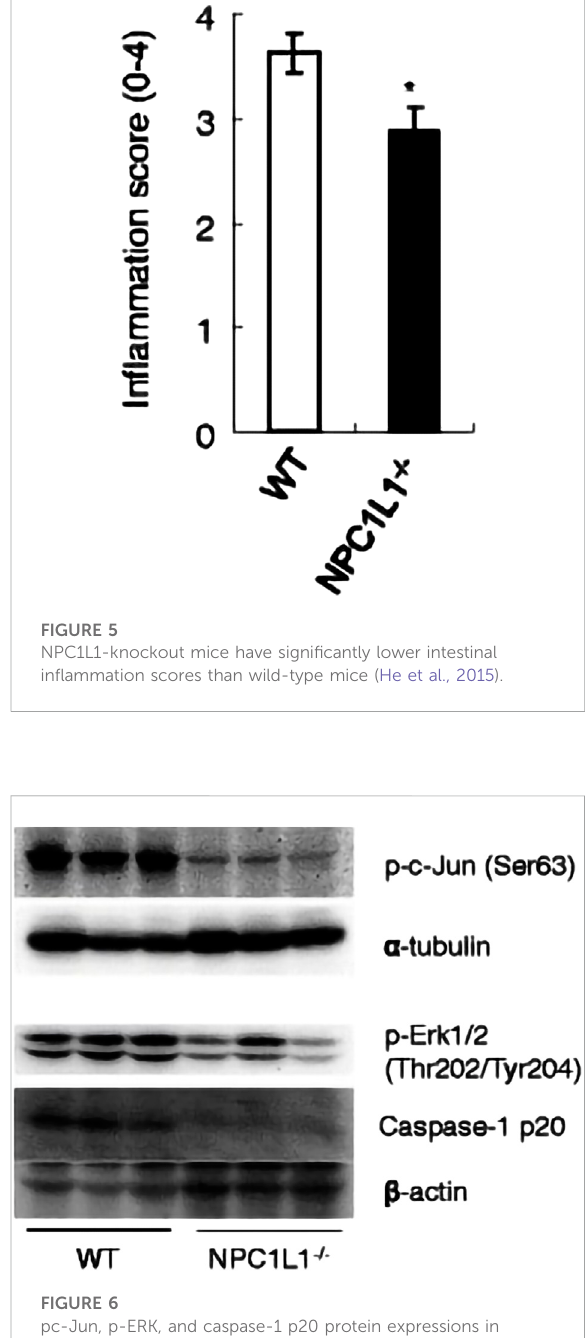
pc-Jun, p-ERK, and caspase-1 p20 protein expressions in tumorsmeasuredbyproteinblotting.pc-Jun,p-ERKandcaspase- 1 p20 were signi fi cantly reduced by NPC1L1 knockdown. pc-Jun, p-ERK, and caspase-1 p20 were also reduced by NPC1L1 knockdown (He et al.,